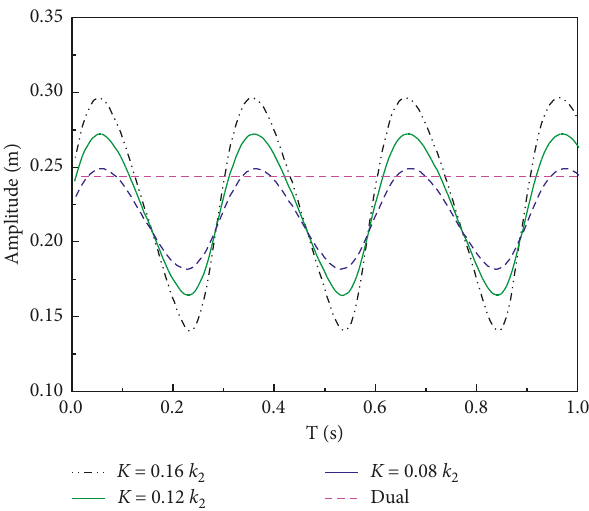
Figure 5: Variation of vibration amplitude of m 2 with time-delay parameter T under different strength parameters K . Figure 7: Variation of galloping amplitude with wind speed under different time-delay parameters T and strength parameters K .